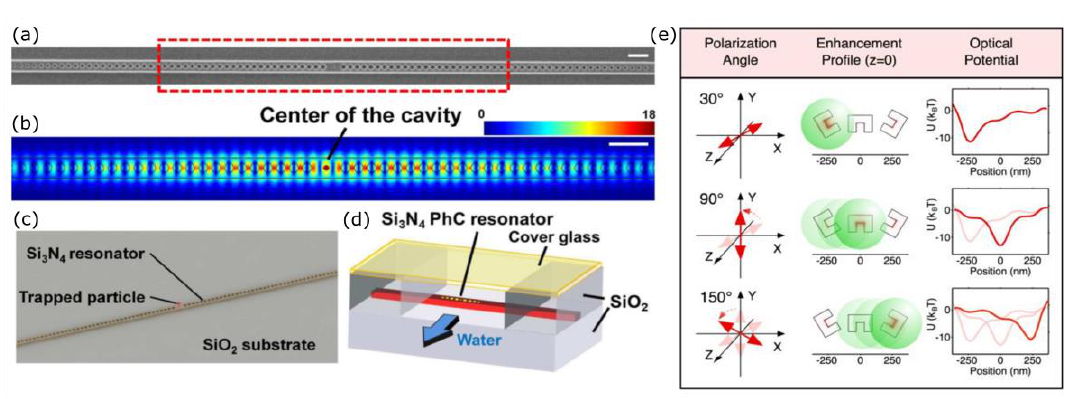
Figure 5. ( a – d ): One-dimensional (1-D) photonic crystal for particle trapping (Reprinted with permission from [119]. Copyright 2012 American Chemical Society: scanning electron microscope image of the resonant cavity ( a ), numeric simulation of the electric field intensity in the center of the cavity highlighted with a red dashed rectangle in the panel ( b ), schematics of the setup for trapping experiments ( c , d ). ( e ) Drawing illustrating how the rotation of electric field polarization results in the excitation of the structure aligned perpendicularly to it, moving the PS sphere towards the position of minimum optical potential (Reprinted with permission from [121]. Copyright 2014 American Chemical Society).